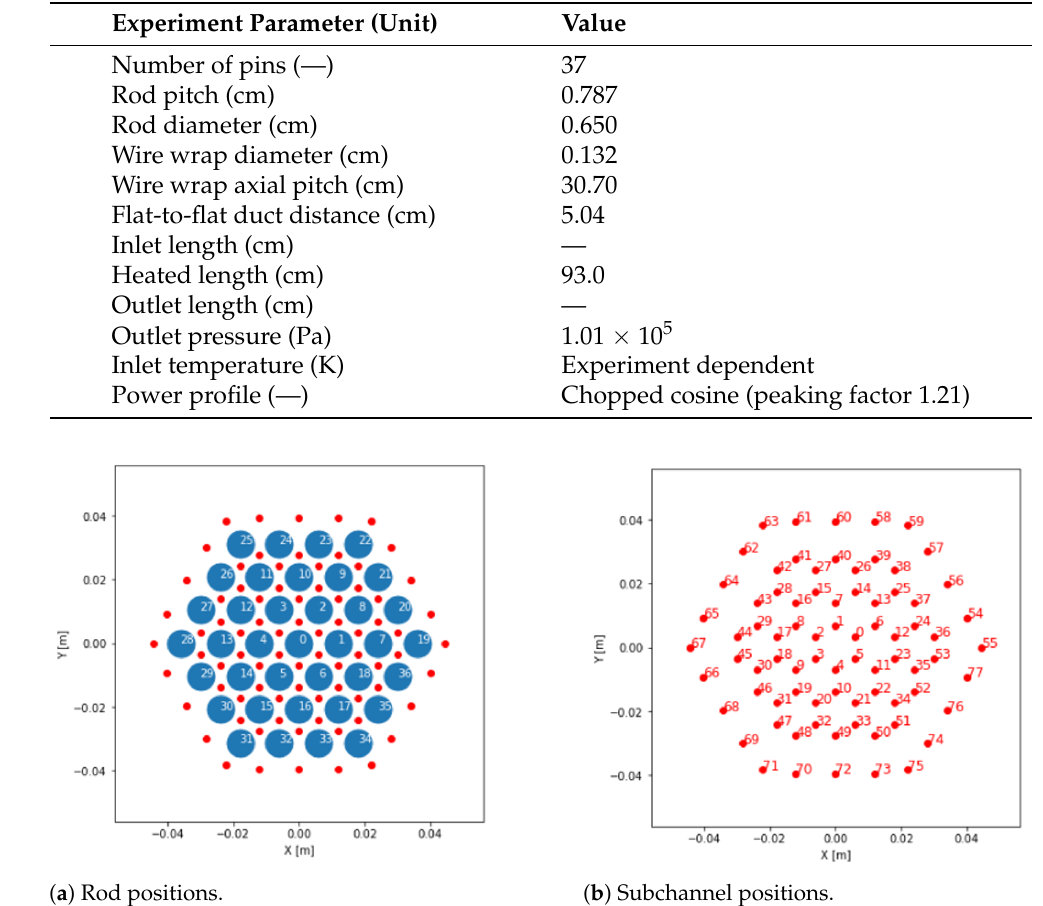
Table 5. Design and operational parameters for Toshiba’s 37-pin benchmark.